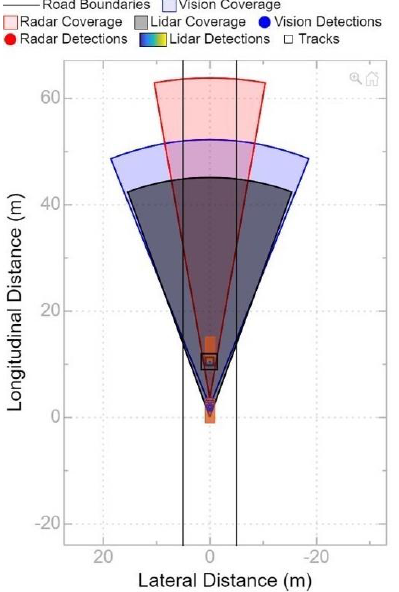
Figure 12. Bird ’s -eye view of the vehicle with three sensors. Figure 12. Bird’s-eye view of the vehicle with three